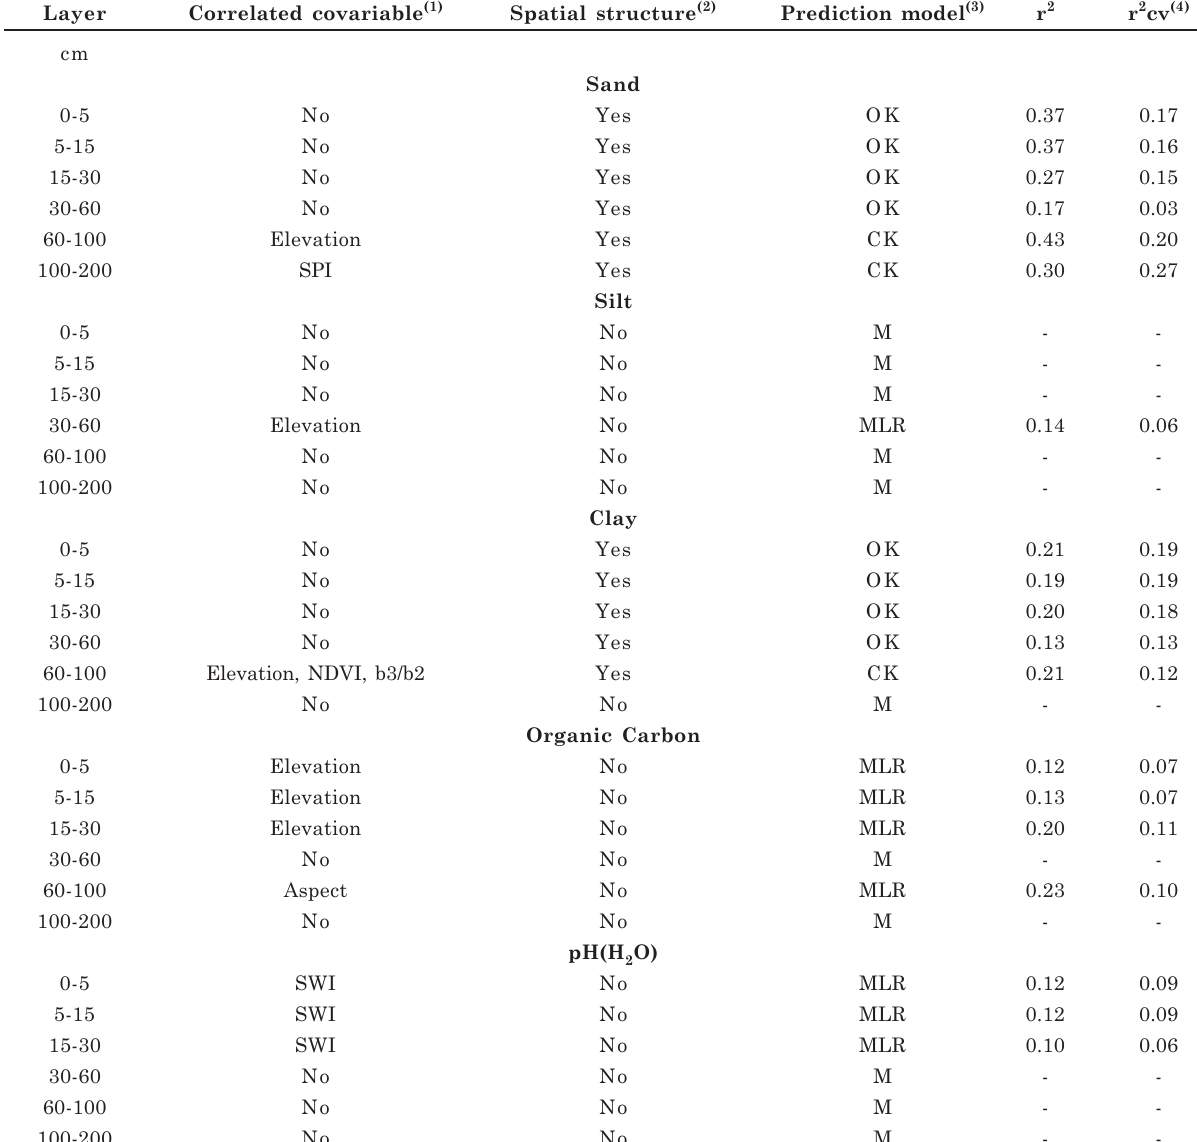
(1) Covariate correlated with ƿ -value<0.005; (2) spatial structure with ƿ -value<0.10; (3) M-medium; OK-ordinary kriging; CK-co- kriging; MLR-multiple linear regression; (4) cross-validated r 2